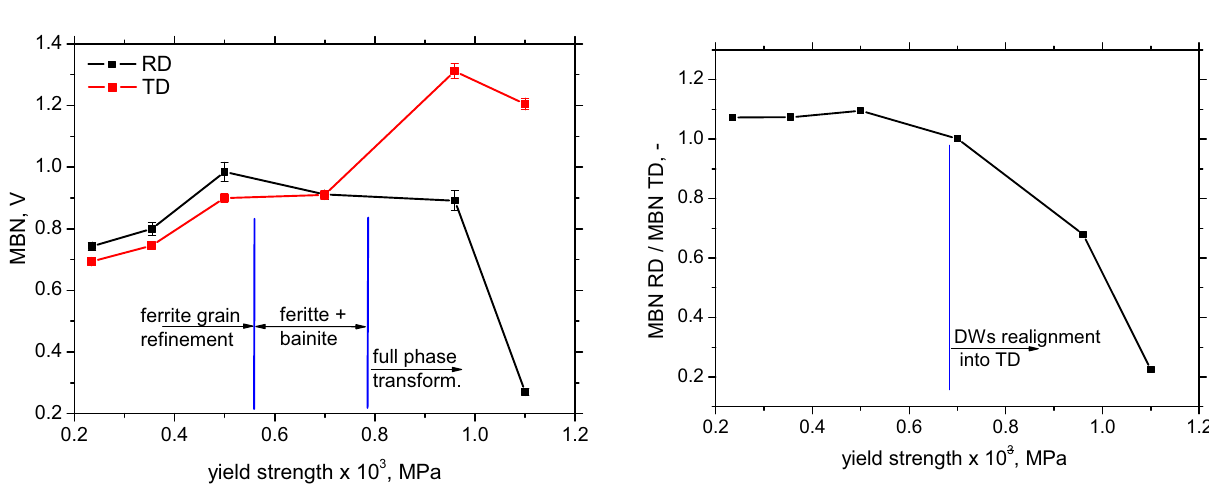
Figure 11. Evolution of MBN and MBN